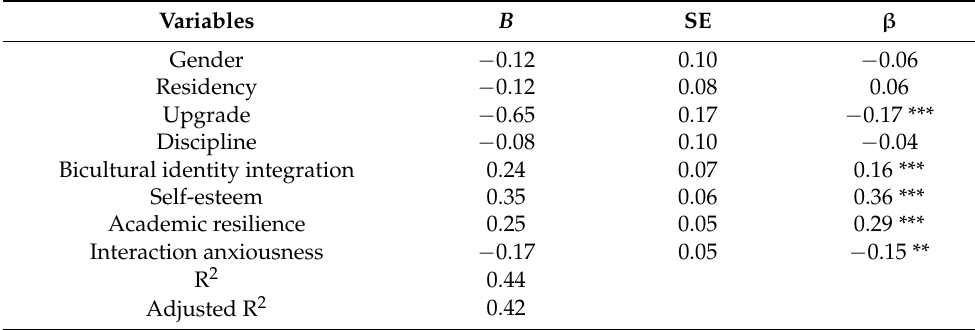
Table 4. Regression analysis for school belonging.